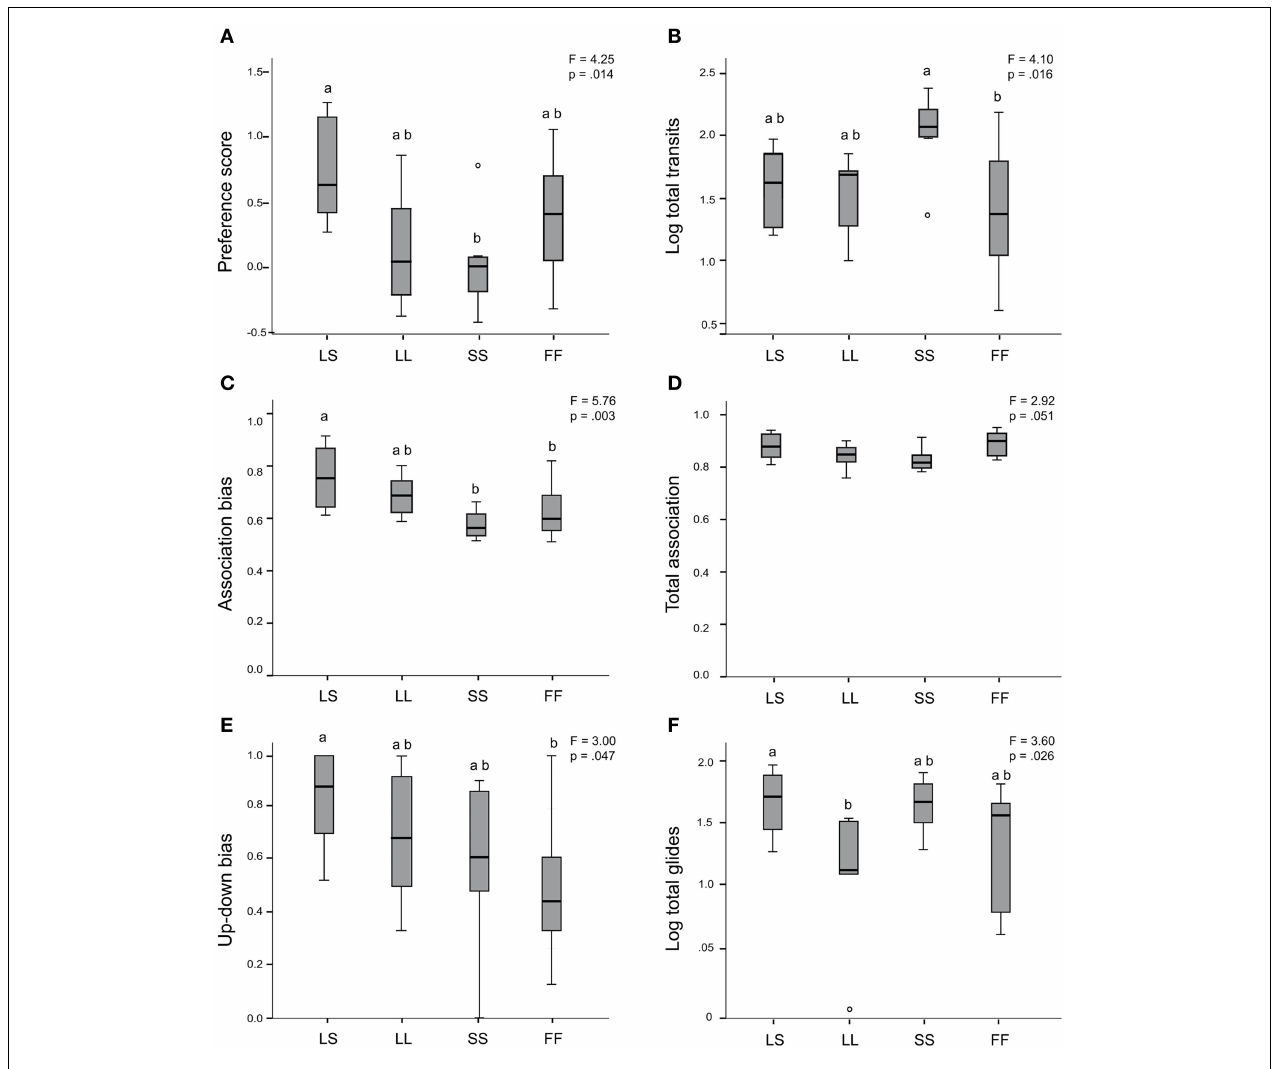
significantly different between groups (B,F) . Box plots indicate first and third quartiles, the line indicates the median, and the whiskers indicate high and low values. Circles indicate outliers. LS, large male/small male exposure; LL, large male/large male exposure; SS, small male/small male exposure; and FF, female/female-exposure. Glide bias and total up-down swims not